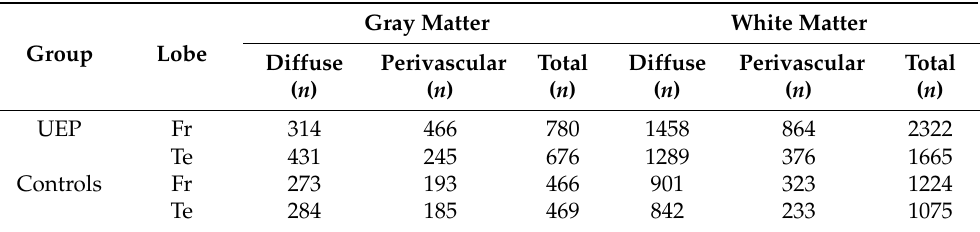
Table 4. An arrangement of total CD68 positive cells in samples of the frontal and temporal lobes of UEP individuals and control group.